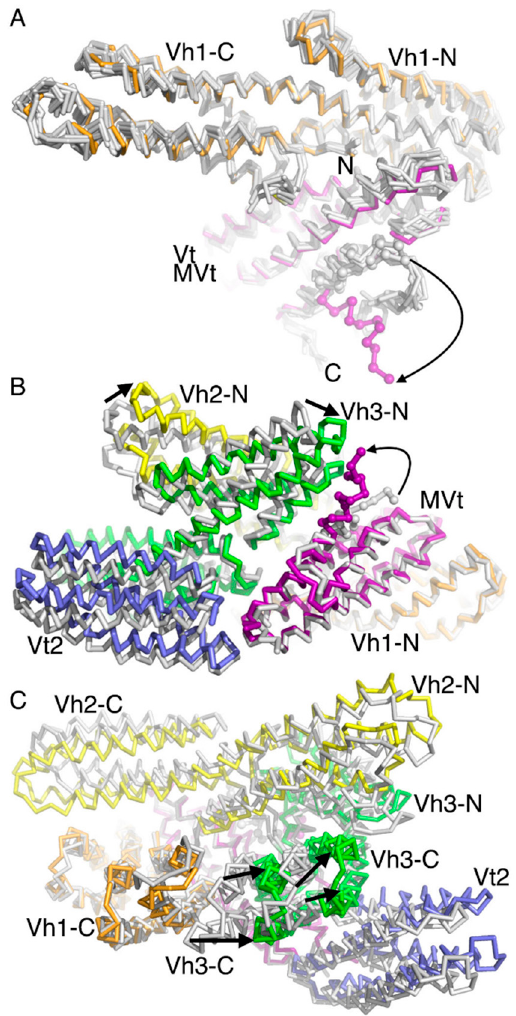
Figure 4. Interdomain distinctions between the H1’-parallel and H1’-kinked metavinculin conformers. ( A ) Superposition of both Vh1 subdomains (Vh1-N for N-terminal and Vh1-C for C-terminal, residues 2–250) and tail MVt (residues 975–1114; Vt in vinculin) domains from our two vinculin subunits in the crystal, our four metavinculin subunits in the crystal, and our three cryogenic electron microscopy structures (all in gray except for the H1’-kinked metavinculin conformer where Vh1 is in orange and MVt in violet) shows that these two domains are almost identical. C α positions 961–972 of the three cryogenic electron microscopy structures are highlighted as spheres to show the novel kink in the isoform-specific H1’ α -helix (arrow). The termini (residues 1 and 1119) are labeled as N and C, respectively. ( B ) Superposition of the Vh1 (residues 2–250) and MVt (residues 975–1114) domains from our H1’-kinked (with domains colored spectrally: Vh1, orange; Vh2, yellow; Vh3, green; Vt2, blue; MVt, violet) and H1’-parallel (shown in gray) metavinculin cryogenic electron microscopy structures. C α positions 961–972 of the three cryogenic electron microscopy structures are highlighted as spheres to show the novel kink in the isoform-specific H1’ α -helix (arrow). Several subdomains are labeled, and their relative movements are indicated. ( C ) Superposition of the Vh1 (residues 2–250) and MVt (residues 975–1114) domains from our H1’-kinked (with domains colored spectrally) and H1’-parallel (shown in gray) metavinculin cryogenic electron microscopy structures. Several subdomains are labeled, and the relative movements of the 4 α -helices of the C-terminal Vh3 subdomain are indicated.